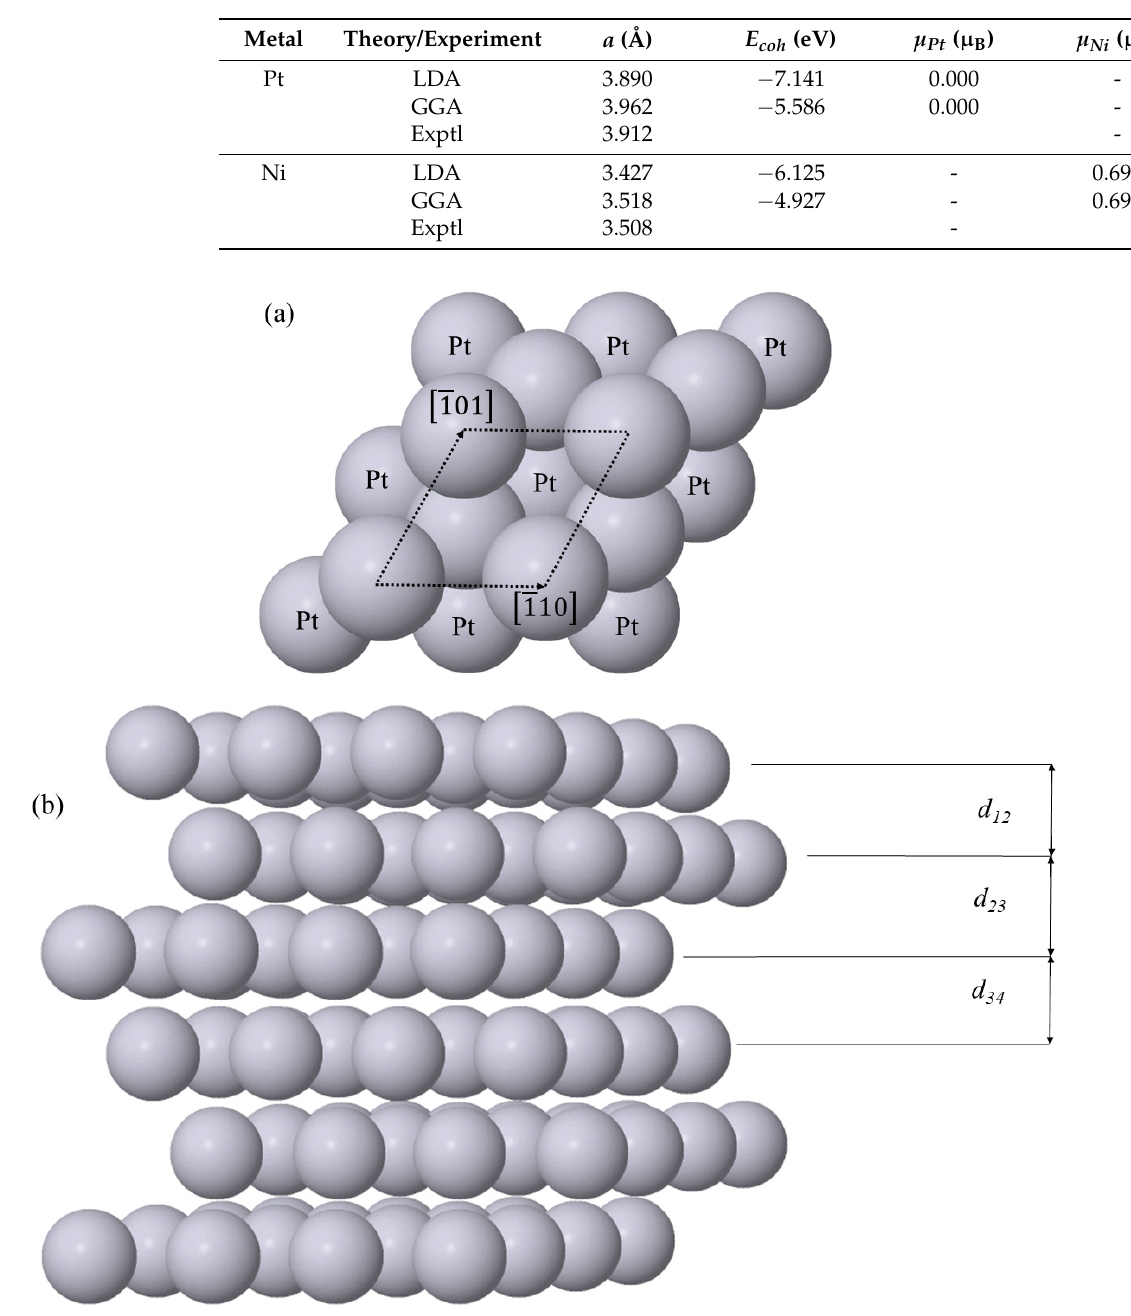
Figure 3. Structure of the ( a ) surface and ( b ) cross-section of Pt(111). In the latter, d 12 , d 23 and d 34 are the surface-second layer, second-third layer and third-fourth layer spacings, respectively.